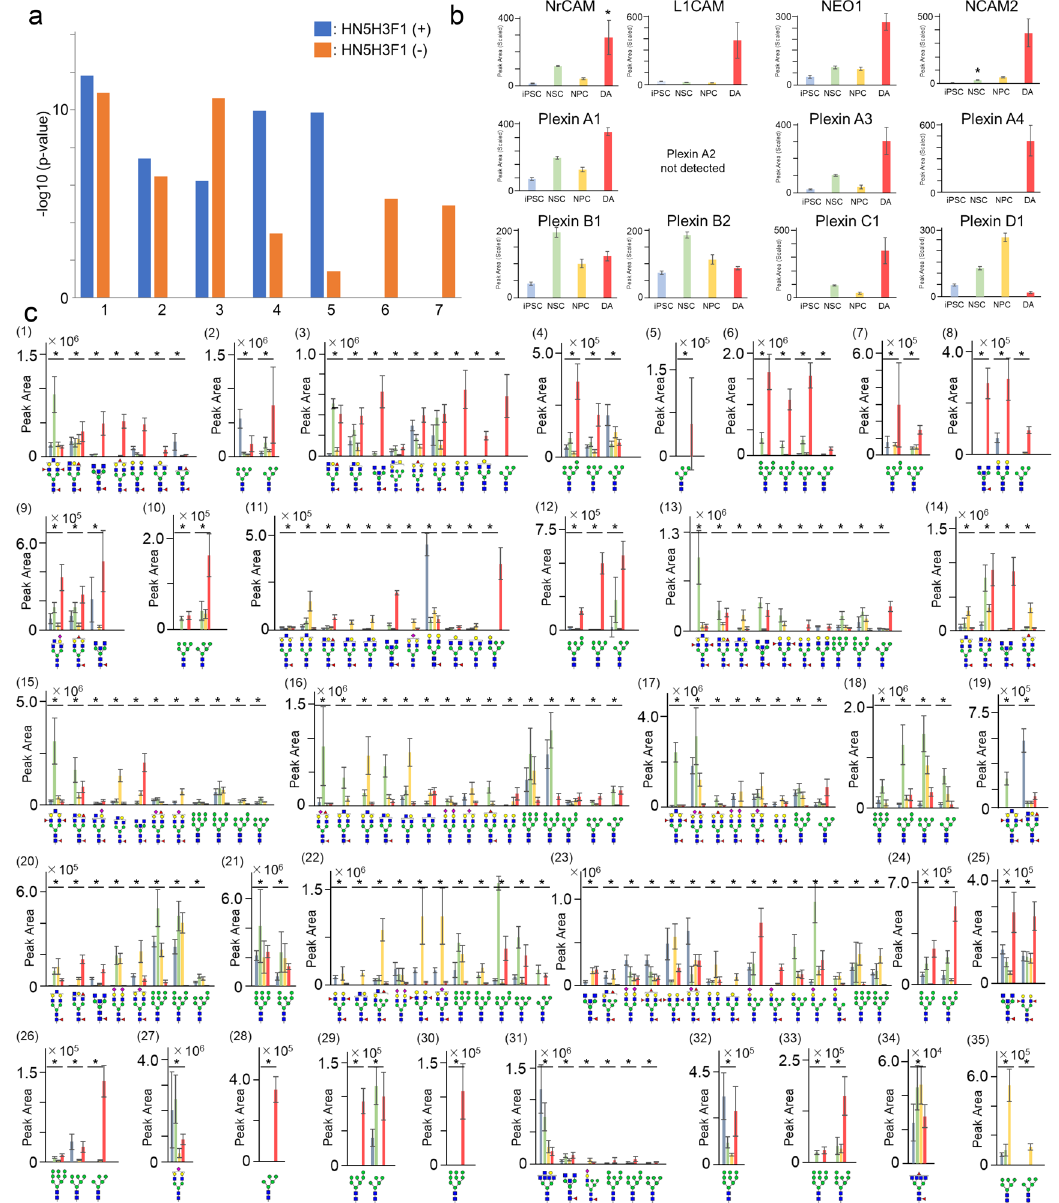
Figure 5. Analysis of the HN5H3F-modified glycoproteins. ( a ) The GO enrichment analysis of the HN 5 H 3 F- modified and unmodified proteins in the DAs. (1) Cell adhesion, (2) homophilic cell adhesion via membrane adhesion molecules, (3) axon guidance, (4) semaphorin-plexin signaling pathway, (5) negative chemotaxis, (6) ion transmembrane transport, (7) extracellular matrix organization. ( b ) The levels of NrCAM, L1CAM, NCAM2, NEO1, and plexins A1–A4, B1, B2, C1, and D1 proteins in the iPSCs, NSCs, NPCs, and DAs. *: Adj. p value < 0.05. ( c ) Glycoform peak area of plexins. Blue bar: iPSC, Green bar: NSC, Yellow bar: NPC, Red bar: DA. (1) PlexinA1 N74, (2) PlexinA1 N700, (3) PlexinA1 N1042, (4) PlexinA1 N1091, (5) PlexinA2 N73, (6) PlexinA2 N156, (7) PlexinA2 N653, (8) PlexinA3 N56, (9) PlexinA3 N1008, (10) PlexinA3